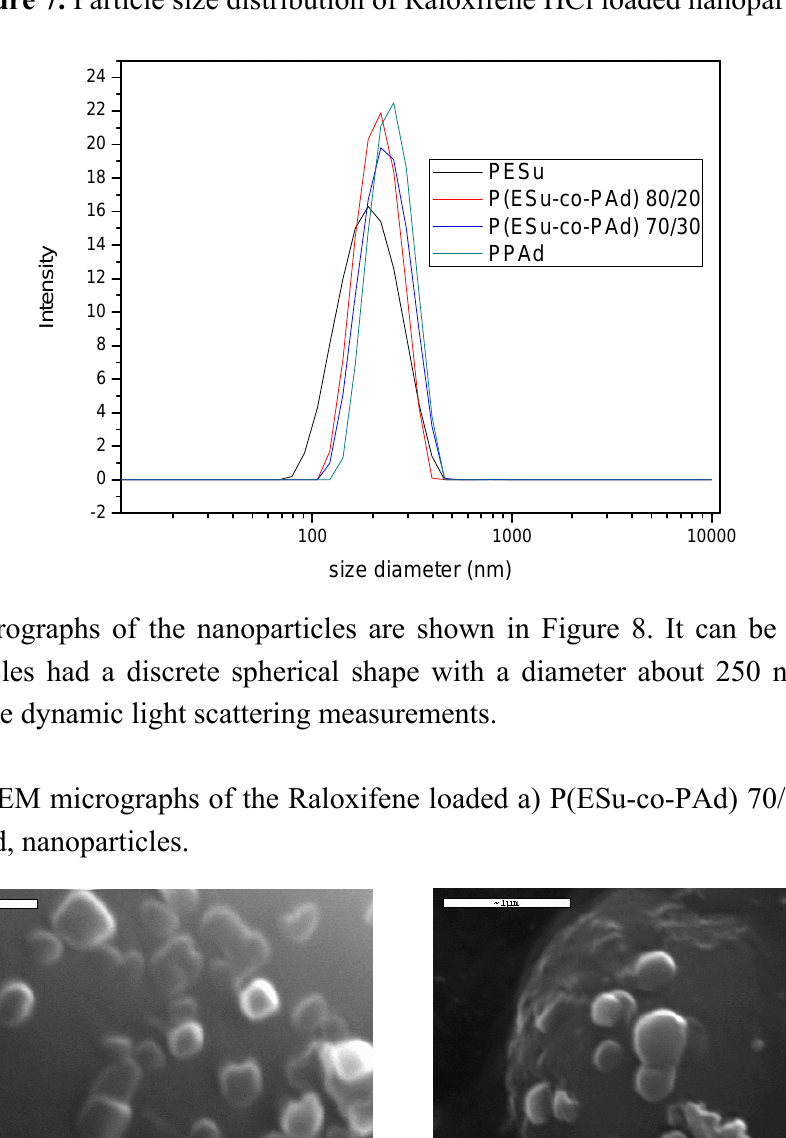
Figure 7. Particle size distribution of Raloxifene HCl loaded nanoparticles.